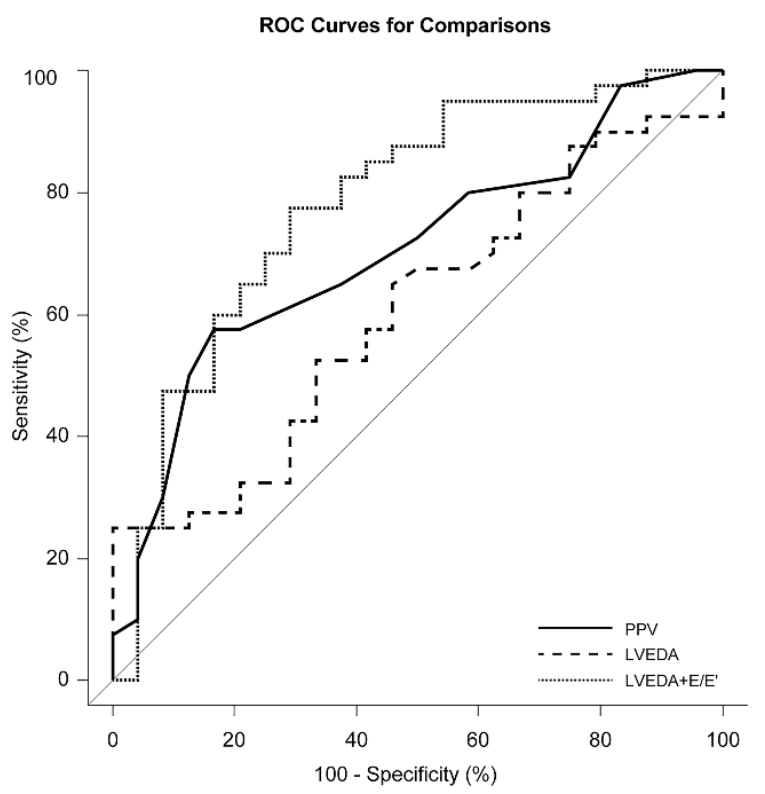
Figure 1. Comparison of receiver operating characteristic (ROC) curves of pulse pressure variation (PPV; solid line; AUROC, 0.70; 95% CI, 0.57 – 0.83; p = 0.002), left ventricular end-diastolic area (LVEDA; dashed line; AUROC, 0.60; 95% CI, 0.46 – 0.74; p = 0.170) and combination of LVEDA and the ratio of early transmitral flow velocity to early diastolic velocity of the mitral annulus (LVEDA + E/E’; dotted line; AUROC, 0.78; 95% CI, 0.66– 0.90; p < 0.001). Abbreviations: AUROC, area under the ROC curve; CI, confidence interval.